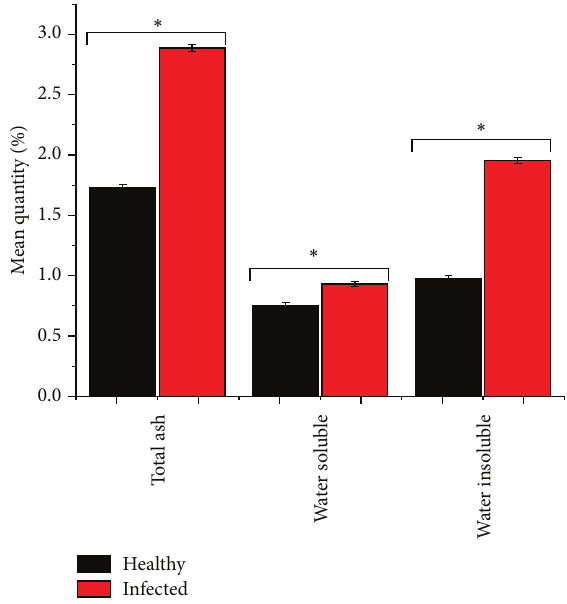
Figure 4: Quantification of ash contents (%) in healthy and infected stem bark of mango suffering from quick decline disease. Each bar represents mean ± SD contents of the specific ash as indicated. ∗ indicates that there was a statistically significant difference between healthy and infected sample at 95%